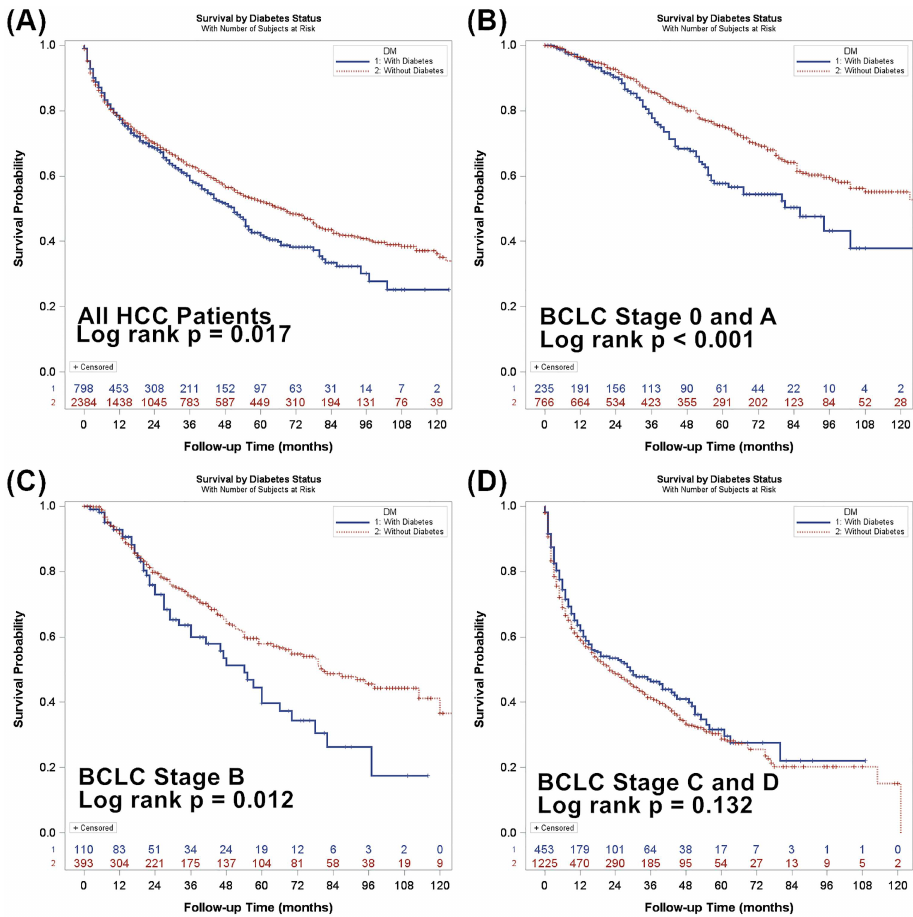
Fig 2. Cumulative survival rates of diabetic and non-diabetic patients among different BCLC staging groups. Differencesin survival betweendiabeticand non-diabetic patients are significantin the wholecohort (p = 0.017, panel A), BCLC stage 0 and stage A (p < 0.001, panel B), and BCLC stage B (p = 0.012, panel C), but not in BCLC stage C and stage D (p = 0.132, panel